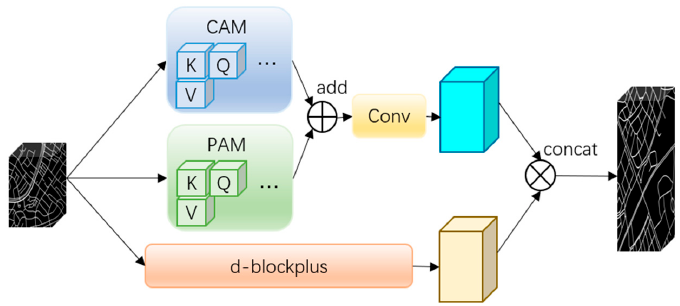
Figure 4. The construction of GIRM.